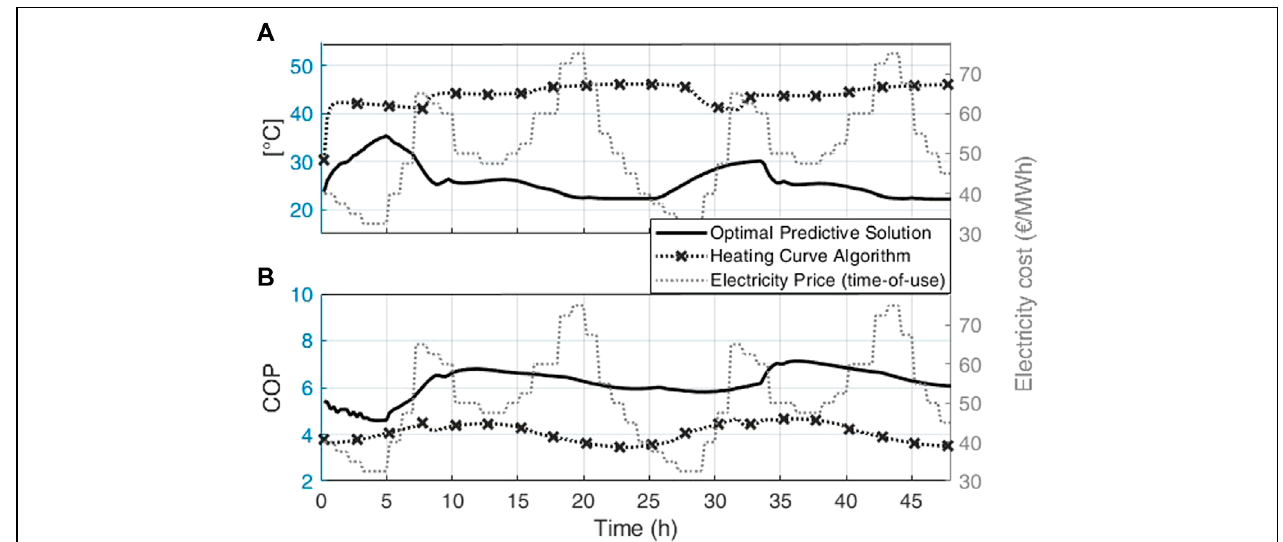
FIGURE 3 | Heat pump performance analysis: (A) Tank temperature, (B) COP comparison.